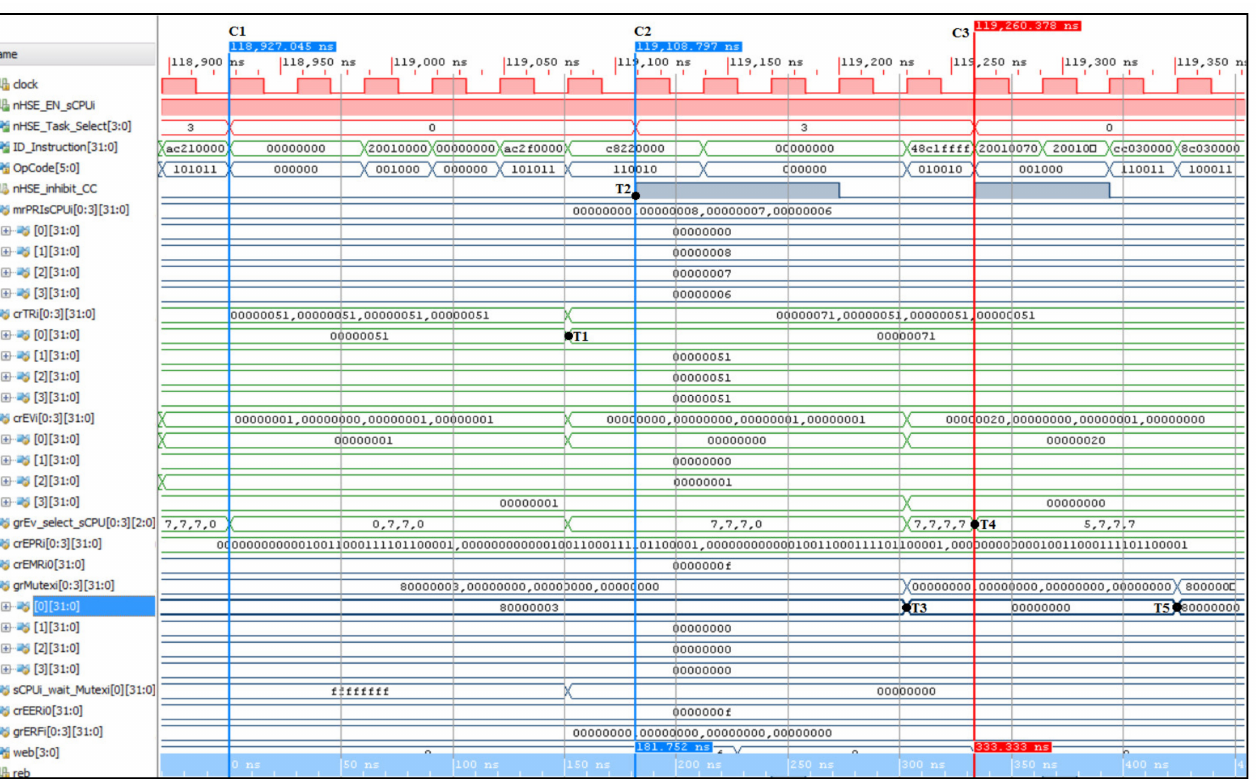
Figure 6. Signals corresponding to the mutexes obtained through the Vivado 2018.2 Design Suite by